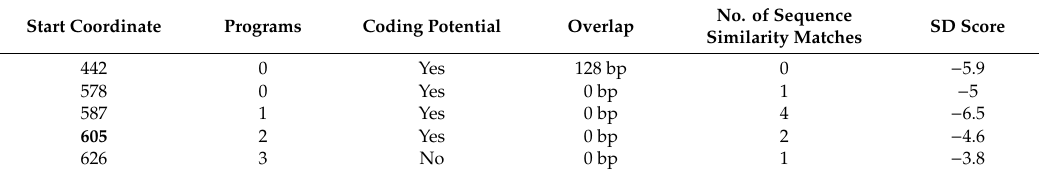
Table 7. An example of a start codon annotation according to our